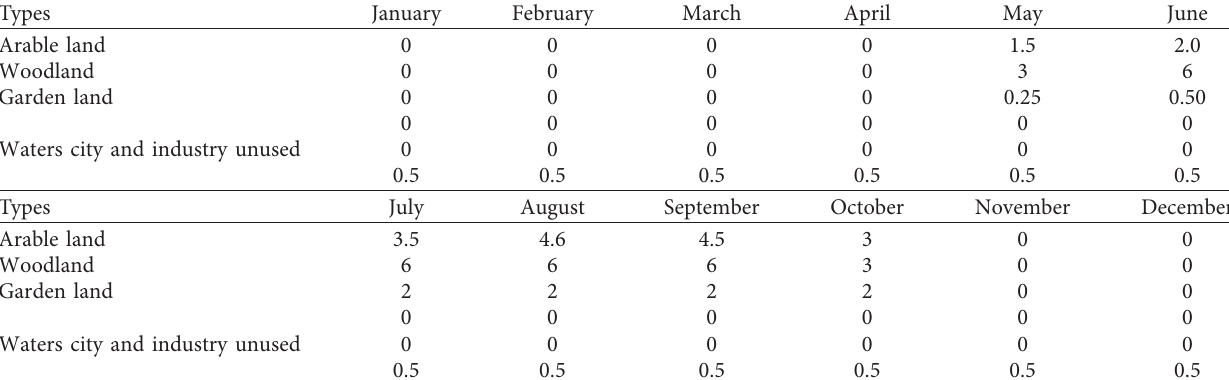
Table 3: Vegetation leaf area index in the Biliu River